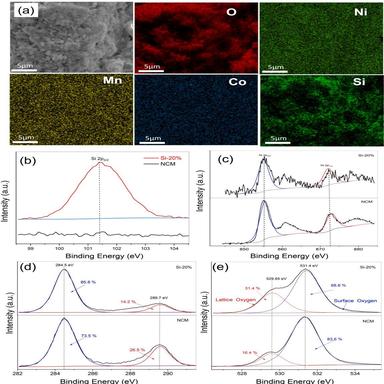
(a) EDS elements mapping of Si-20 %; high-resolution XPS spectra of (b) Si, (c) Ni and (d) C, (e) O for NCM and Si-20 %.